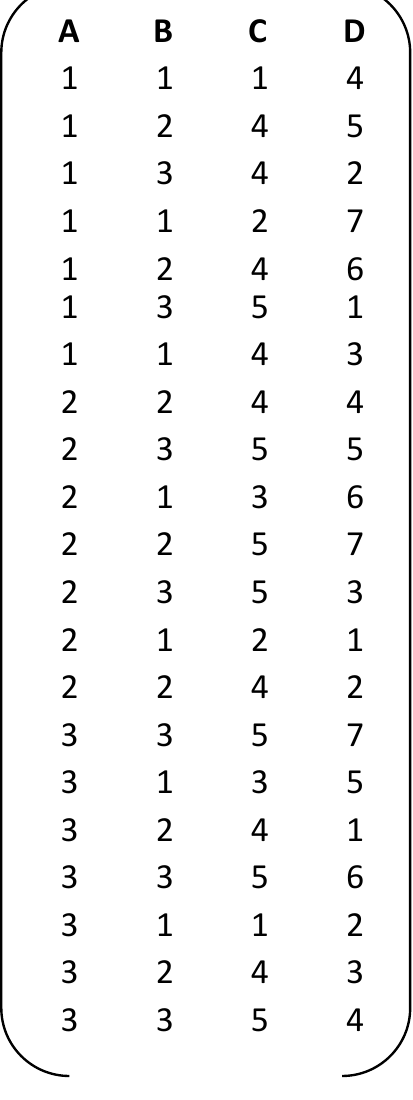
Figure 15. EA (21, 3 2 5 1 7 1 ).